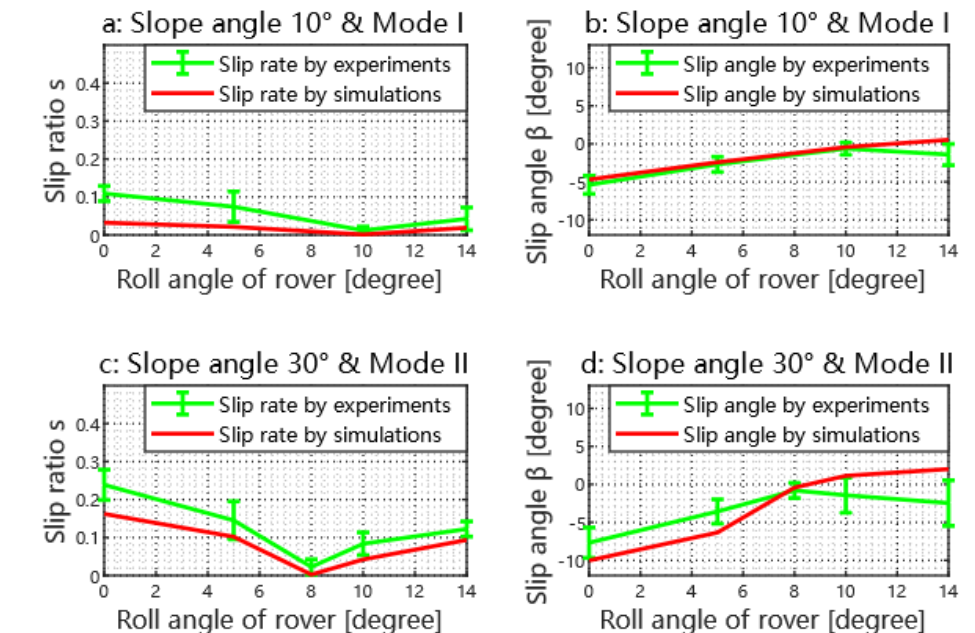
Figure 5. Experimental and simulation results of rover slippages during 10 ◦ and 30 ◦ slope traverses. The wheel’s angular velocity is 20 rpm. Sub-figures ( a , b ) show the slip ratio and angle for the rover traversing on a 10 ◦ slope in mode I, while the conditions of sub-figures ( c , d ) are the mode II and 30 ◦ slope. We measure the slip parameters of the rover as it traverses the slope at different flow angles.